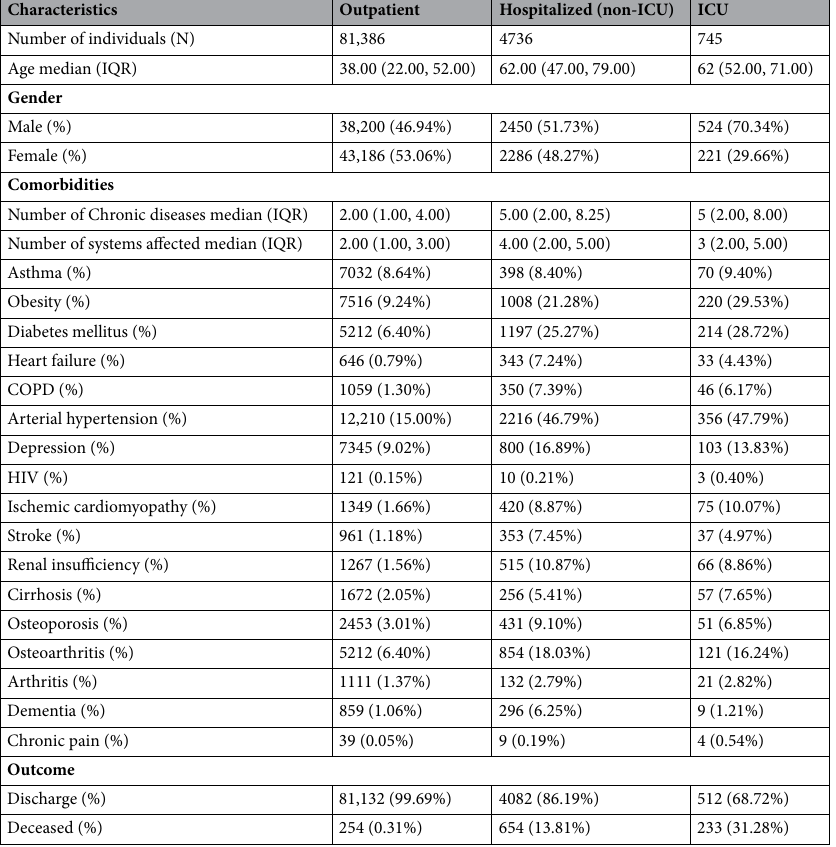
Table 1. Demographic characteristics, comorbidities, and final outcome of different types of COVID-19 patients. Continuous data are reported as median with interquartile range (Q3–Q1), and categorical data are expressed as percentages (%). COPD is chronic obstructive pulmonary disease and HIV is Acquired Immune Deficiency Syndrome. Deceased (report only when the patient